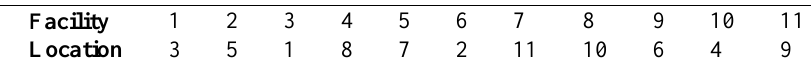
Table 3. Representation of the solution space of